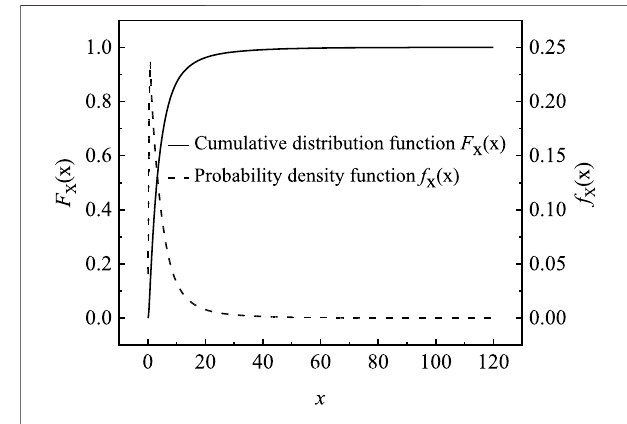
FIGURE 4 | Strength models for different C o values ( A w = 15%, w = 1.5 w L ). FIGURE 5 | Log-normal distribution function [ x ∈ (0.120), ( μ = 1, σ = 1)].